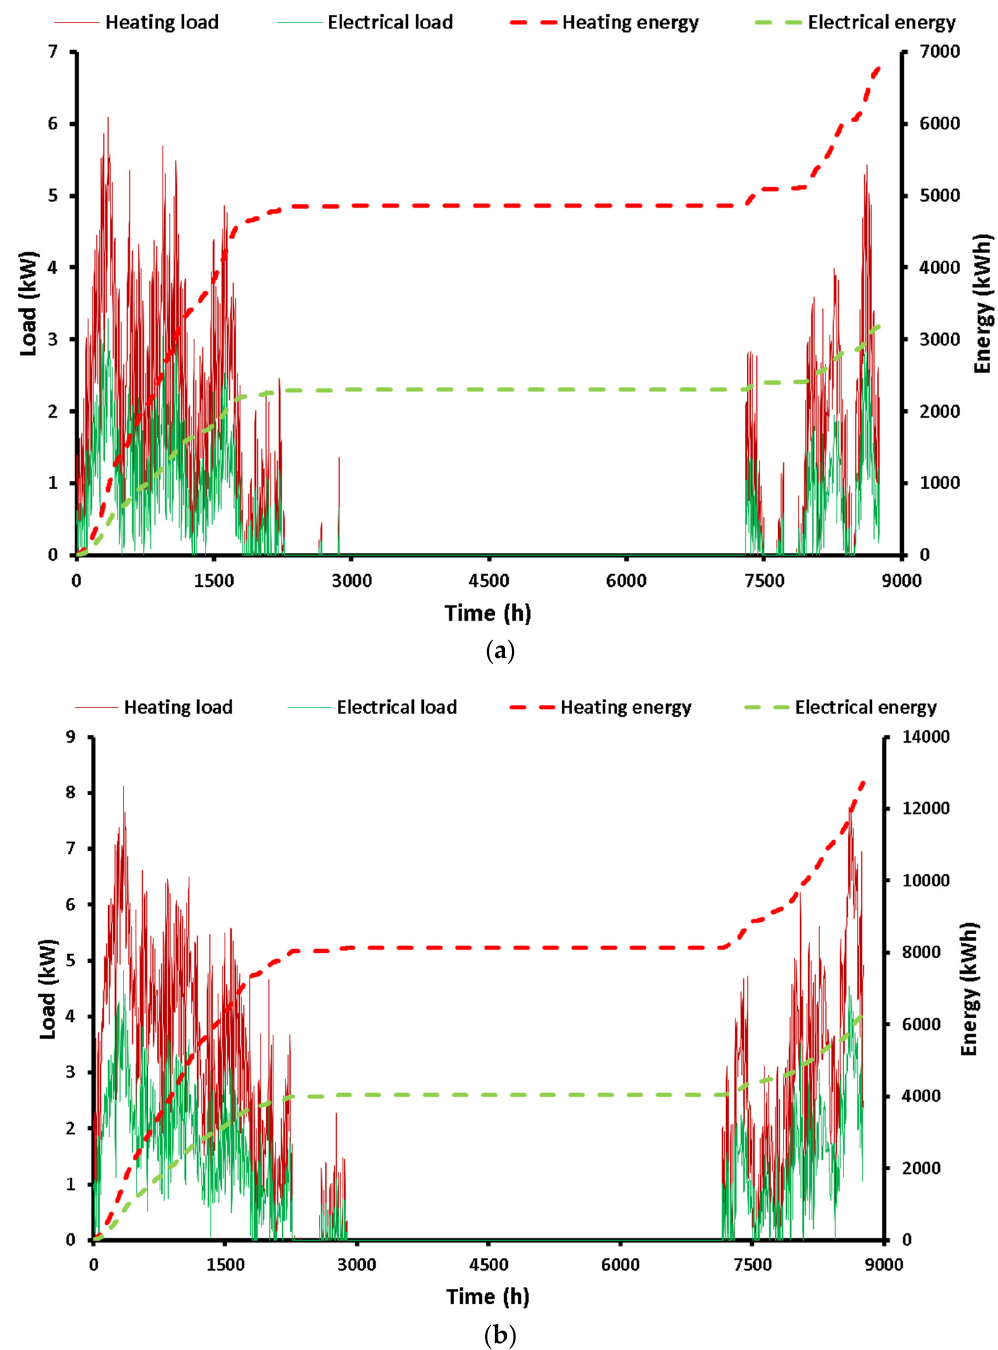
Figure 9. Heat pump system: loads in [W] and cumulative energy in [kWh] for heating for ( a ) Athens (Zone B) and ( b ) Thessaloniki (Zone C).